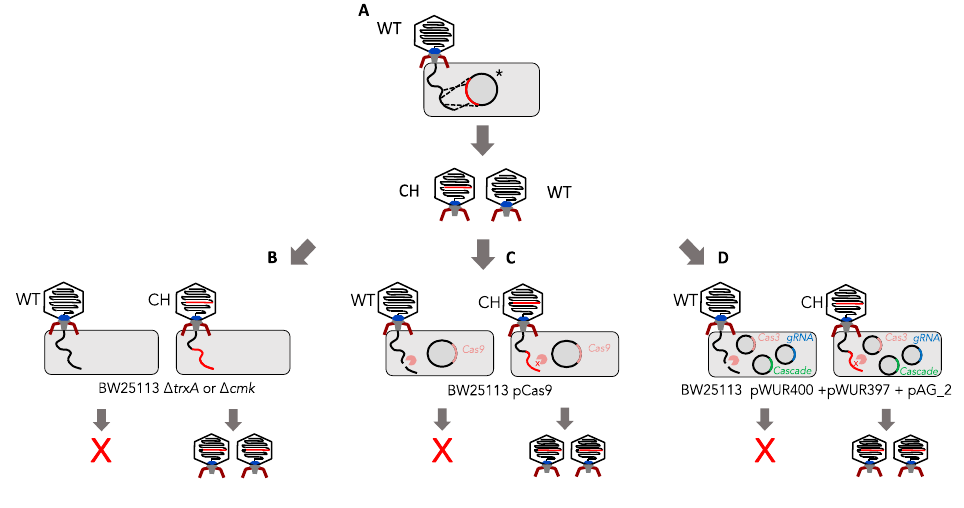
Figure 1. Summary of marker-based vs. marker-less selection methods. ( A ) The homologous recombination step allows for generation of a mixed population of chimeric / mutant (CH) and wild-type (WT) phages. ( B ) Marker-based selection requires a gene encoding an essential host factor to be incorporated into the region that will homologously recombine in step A. Mutants are then selected for on E. coli cells that are deficient in this host factor. For phage T7 either E.coli ∆ trxA or E.coli ∆ cmk can be used for positive selection. ( C ) Type II CRISPR system consists of one vector (pCas9: contains Cas9 as well as direct repeat regions and guide RNA). ( D ) A Type I CRISPR system consists of three vectors (pWUR400:Cas3, pWUR397:cascade system and pAG_2:guide RNA). Both CRISPR systems target wild-type phage, enriching for mutants.